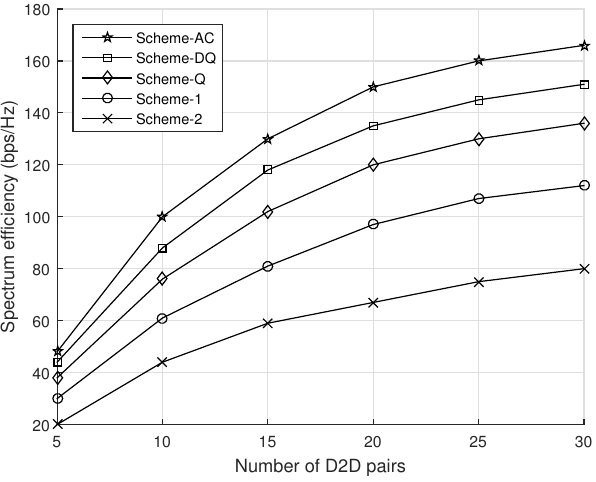
Figure 6. SE versus number of D2D